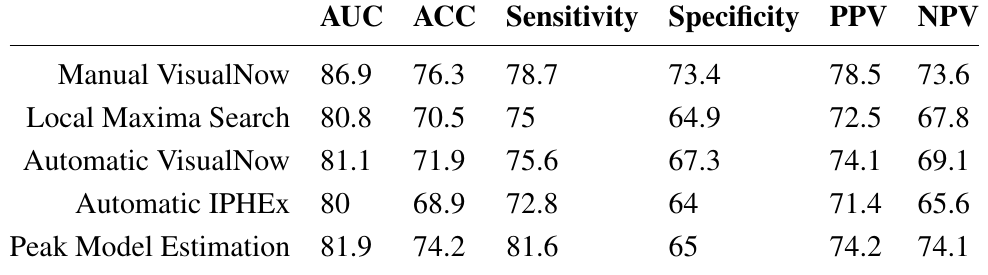
Table 4. Classification Results of the random forest. The quality measures are the AUC, accuracy (ACC), sensitivity, specificity, positive predictive value (PPV) and negative predictive value